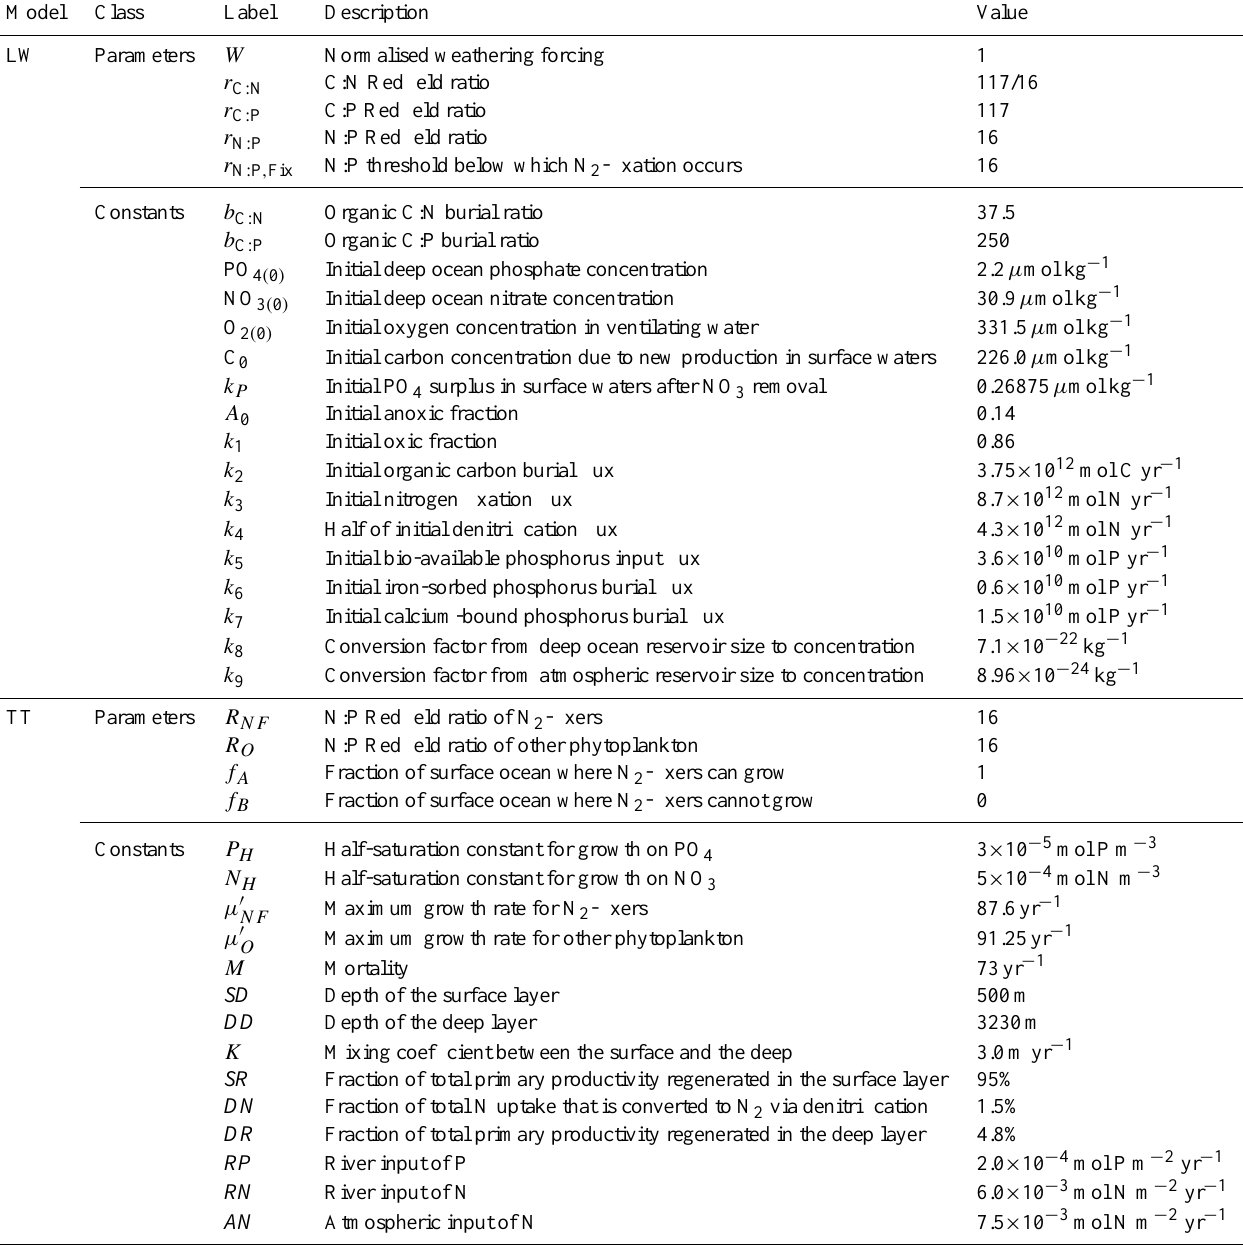
Table 1. Model parameters varied in this study and all remaining model constants.